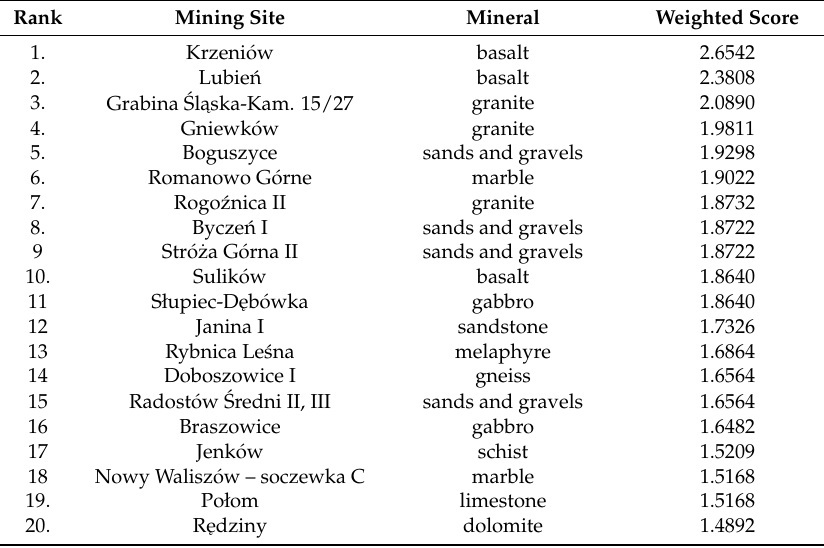
Table 1. Ranking of mining waste sites